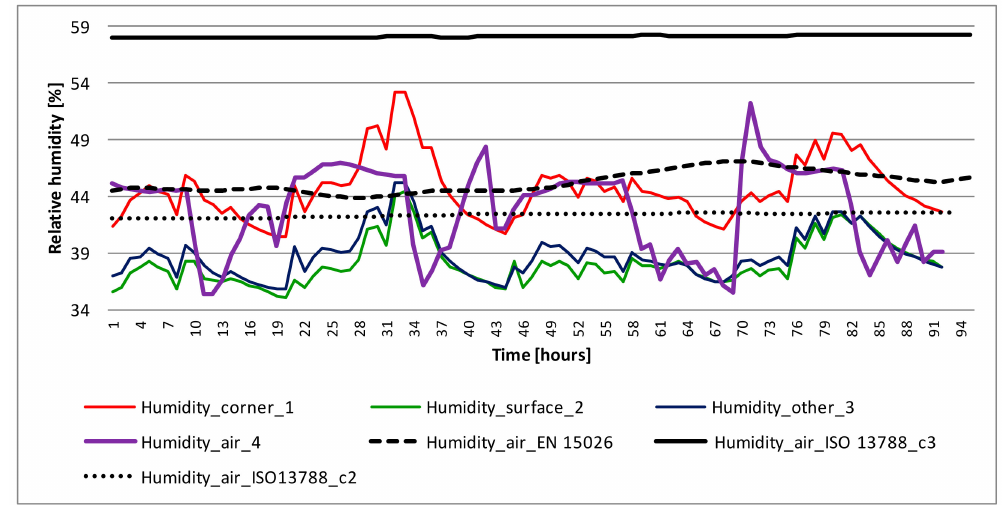
Figure 11. Changes of relative air humidity for the room with external walls W_1 (symbols as in the picture Figure